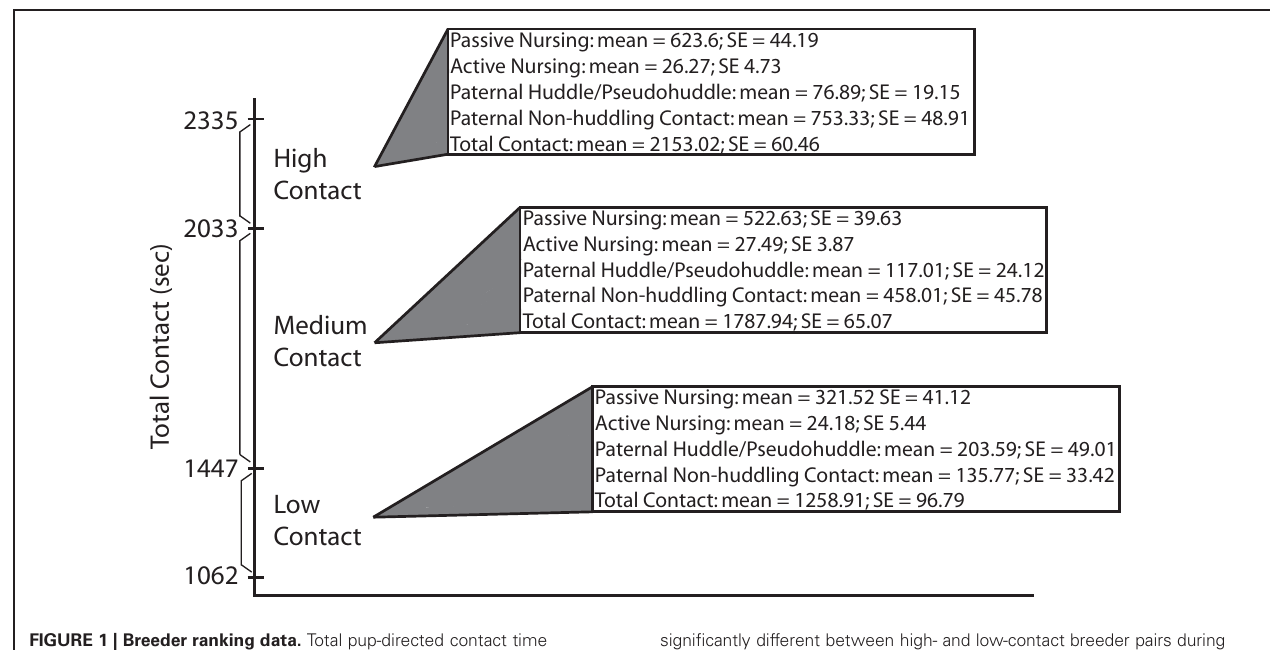
FIGURE 1 | Breeder ranking data. Total pup-directed contact time (in seconds) for high-, medium-, and low-contact breeder pairs. Means and standard errors are also presented for specific parental behaviors found to be